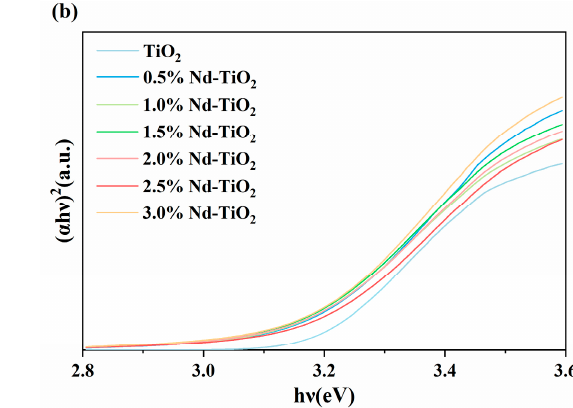
Figure 4. ( a ) UV–Vis absorption spectra of the TiO 2 and Nd-TiO 2 NPs with different Nd 3+ concentrations; ( b ) relationship between ( α h ν ) 2 and photon energy (h ν ) for TiO 2 and Nd-TiO 2 NPs with different Nd 3+ concentrations.